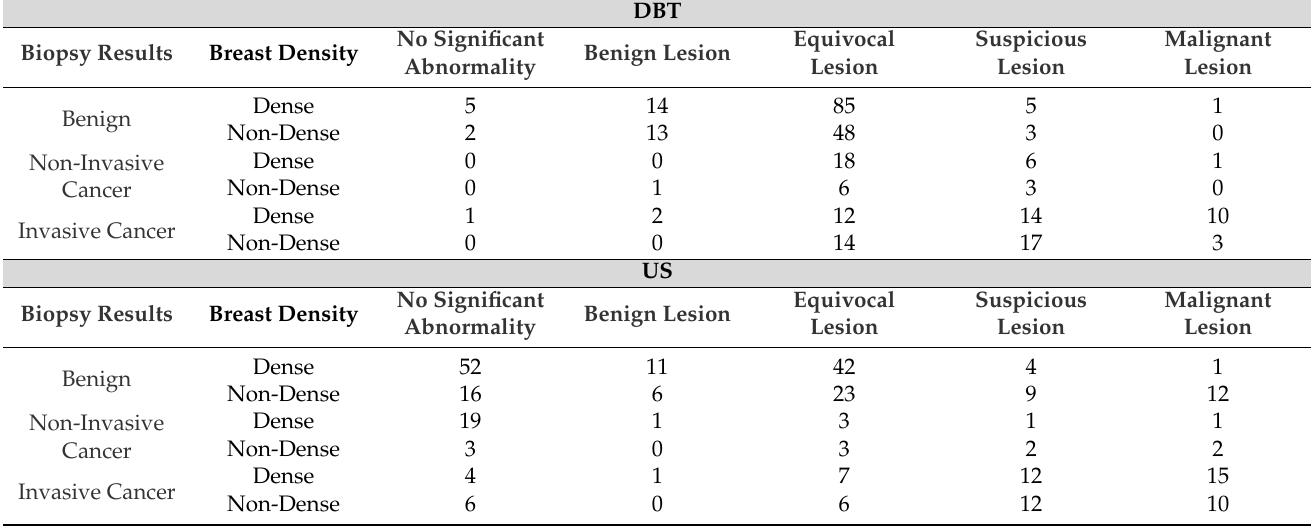
Table 4. The performance of DBT and ultrasound in the categorisation of 284 lesions classified as equivocal (RANZCR 3) on